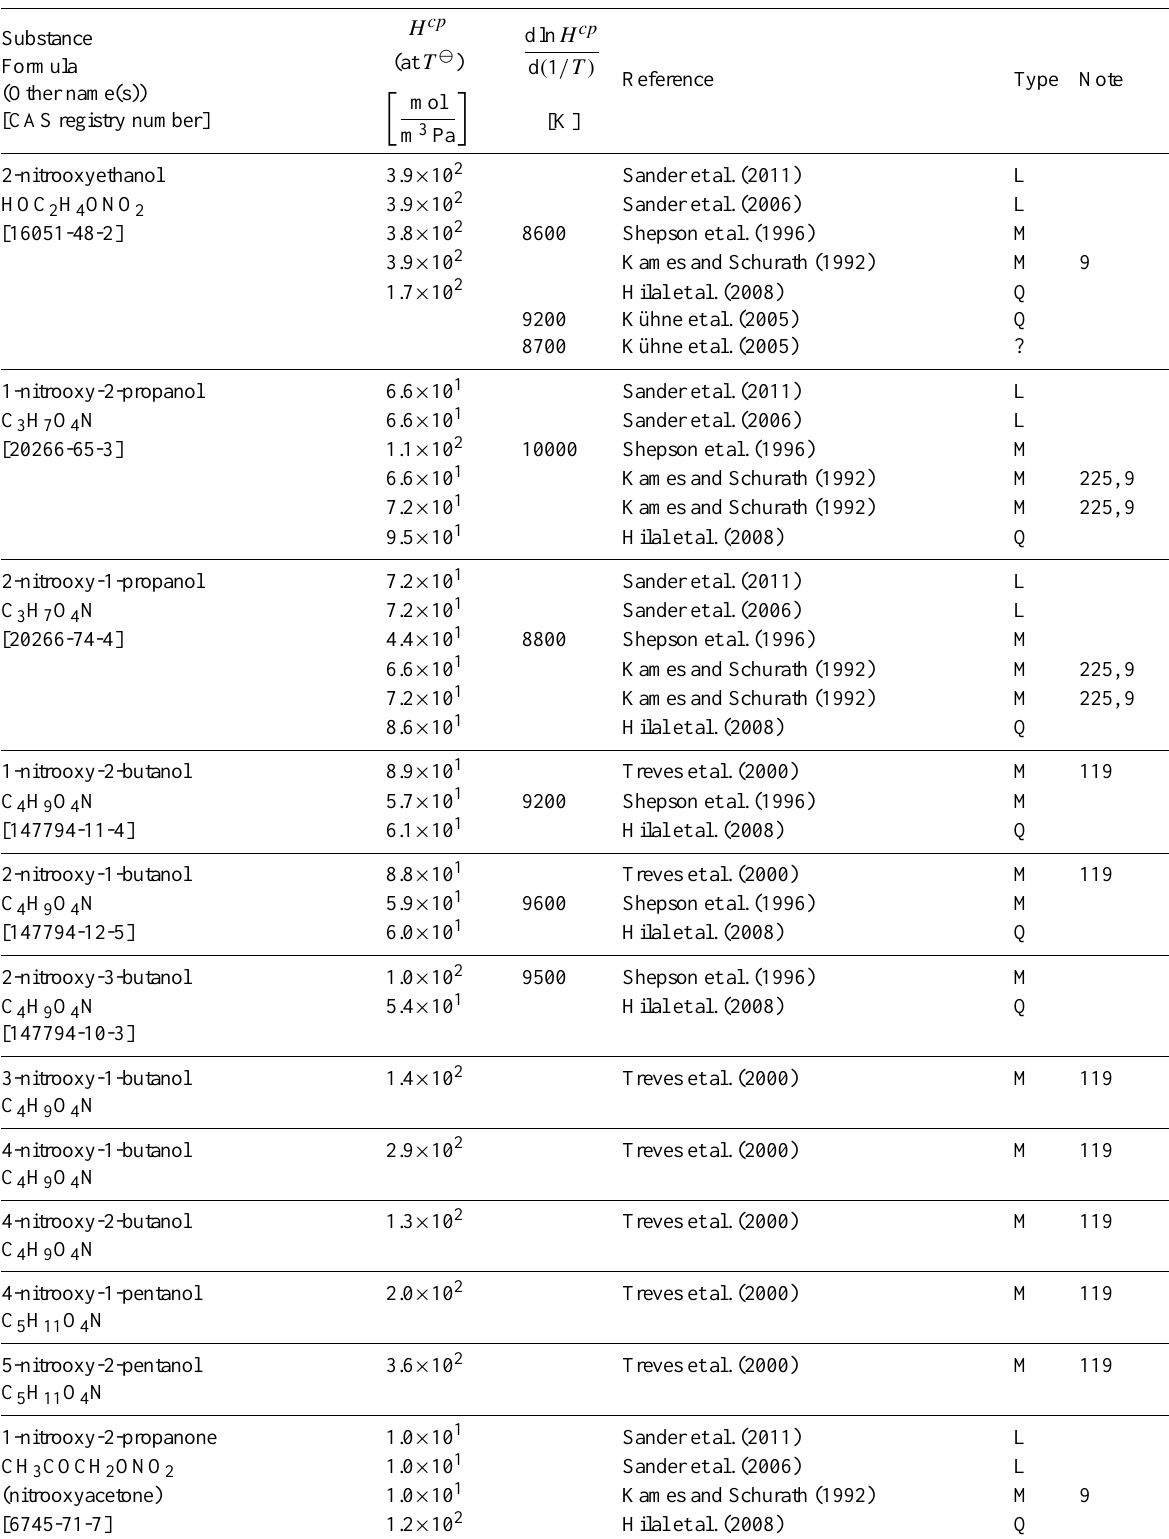
Table 6: Henry’s law constants for water as solvent